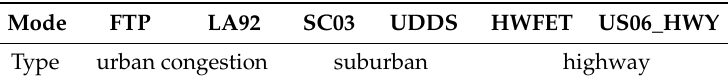
Table 3. Constraints of dynamic performance for the HEV. Table 4. Six types of typical driving cycles.